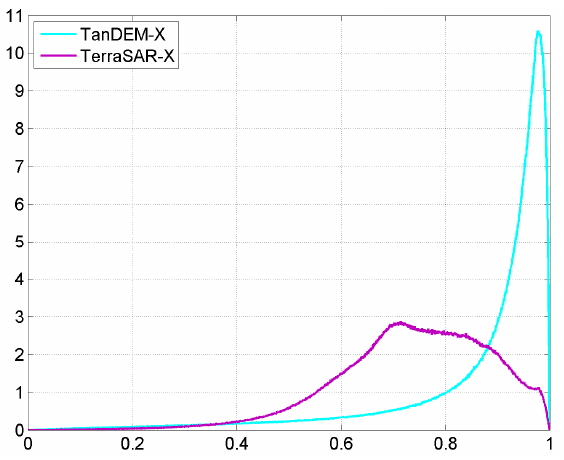
Figure 4. Coherence histogram comparison of single-pass TanDEM-X interferogram and repeat-pass TerraSAR-X interferogram generated from two images with a time lag of 33 days.